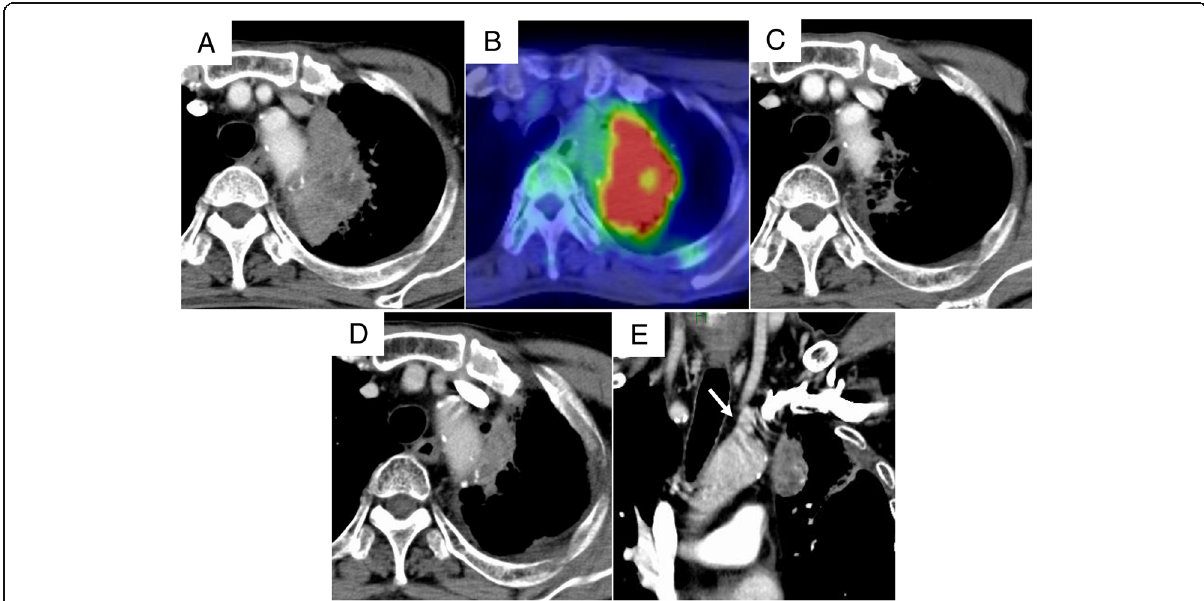
Fig. 1 Chest contrast-enhanced computed tomography (CT) and positron emission tomography (PET)/CT findings. a , b A pulmonary tumor originated from the left upper lobe suspected to have invaded the aorta. c Markedly reduced tumor size following definitive chemo-radiotherapy. d The re-enlargement of primary tumor during steroid tapering. e Aortic invasion localized in the periphery of the left subclavian artery (arrow)